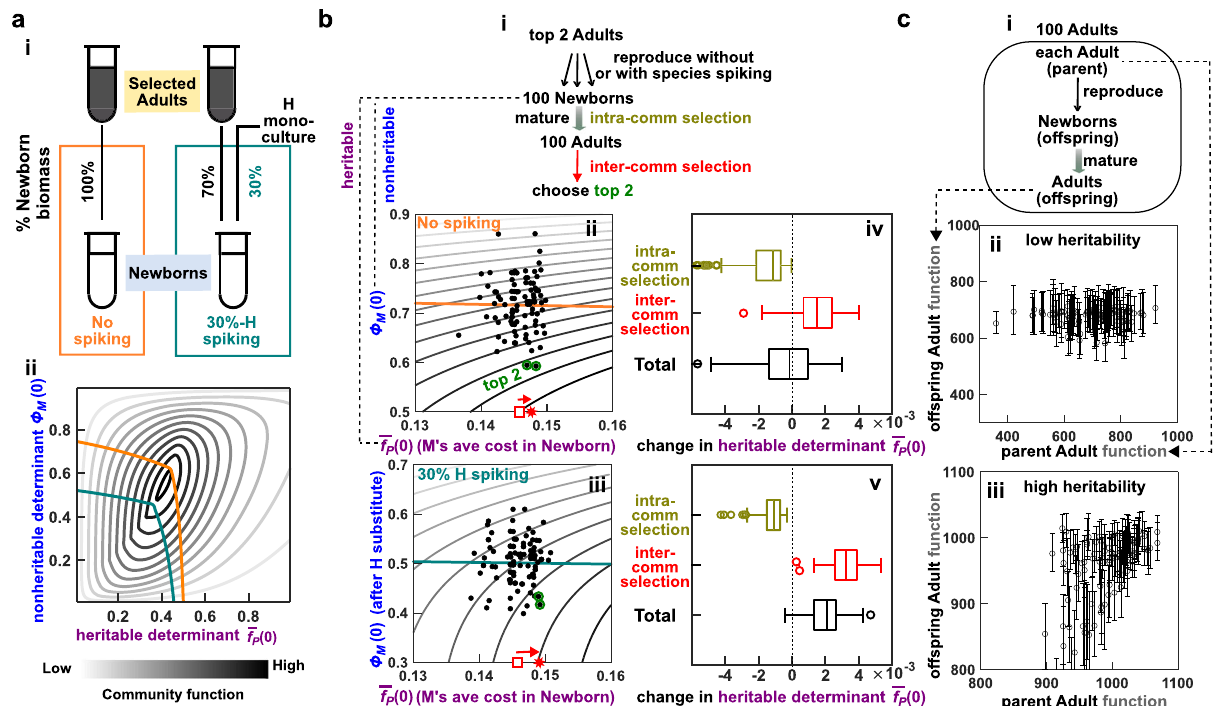
Fig. 5 Increasing community function heritability improves selection ef fi cacy. a Newborn restrictor (orange curve in ii) is shifted down when 30% of the total biomass in a Newborn is replaced by the nonevolving H ( “ 30%-H spiking ” ; teal curve in ii) in every cycle. Because communities are constrained by the Newborn restrictor, we only need to focus on the geometry of the landscape near the restrictor. b Improving community function heritability improves selection ef fi cacy. i : Scheme of community selection over one cycle. ii , iii : Visualization of intercommunity selection on the landscape under the no-spiking strategy and the 30%-H spiking strategy, respectively. The 30%-H spiking strategy is expected to improve community function heritability, since contours near the teal line are more perpendicular to the axis of heritable determinant than contours near the orange line. The top 2 communities chosen to reproduce are highlighted with green circles. The average heritable determinant f P ð 0 Þ over all 100 communities and that over the top 2 are indicated by red open square and red star, respectively. The length of the red arrow indicates the progress in heritable determinant f P ð 0 Þ due to intercommunity selection. iv , v : Progress in the heritable determinant f P ð 0 Þ . In total, 100 repeats of the selection cycle are used to obtain box plots (center: median; bottom and top edges: the 25th and 75th percentiles, respectively; whiskers: data range excluding outliers; open circles: outliers). Although intercommunity selection (red) improves heritable determinant f P ð 0 Þ , intracommunity selection (olive) reduces it. The sum of these two effects is the net progress (black). c Species spiking can improve the heritability of community function. i : Heritability is quanti fi ed by comparing 100 pairs of parent Adult functions and their offspring Adult functions and estimating the slope of the least-squares linear regression. ii : Under the no-spiking strategy, community function heritability is low. iii : Under the 30%-H spiking strategy, community function heritability is high. Circles represent the mean, and error bars extend from 25% to 75% quantile. In (ii) and (iii), error bars are calculated from ~60 to 100 offspring communities, respectively. Empirical determination of heritability as depicted here can be used in lieu of landscape visualization to guide perturbation